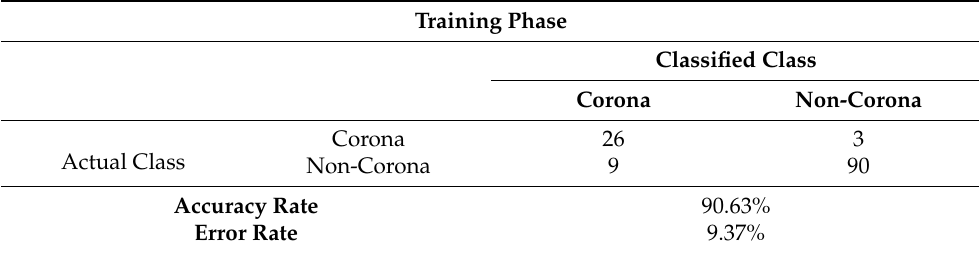
Table 7. Confusion matrix for training phase—time domain corona fault classification.